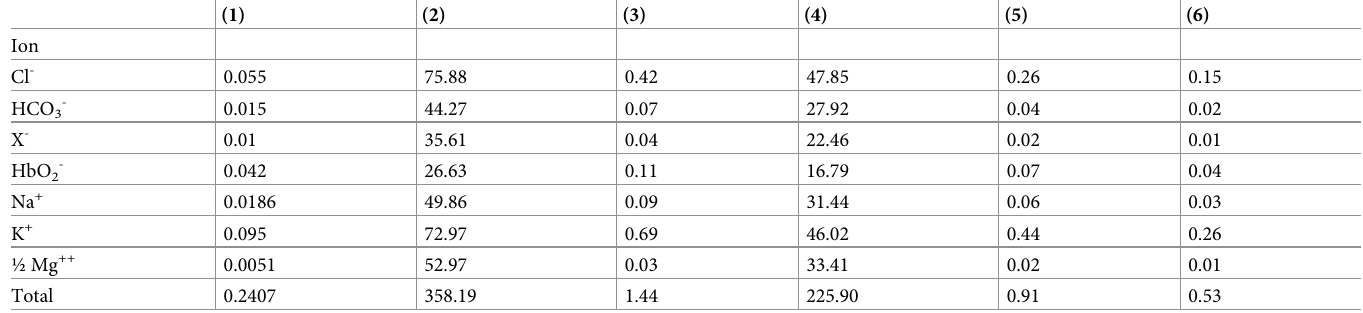
Table 2. Calculation of the internal conductivity of HRBC under physiological conditions using known concentrations of different ionic species and limiting ionic conductance values at 25˚C by Bockris et al.